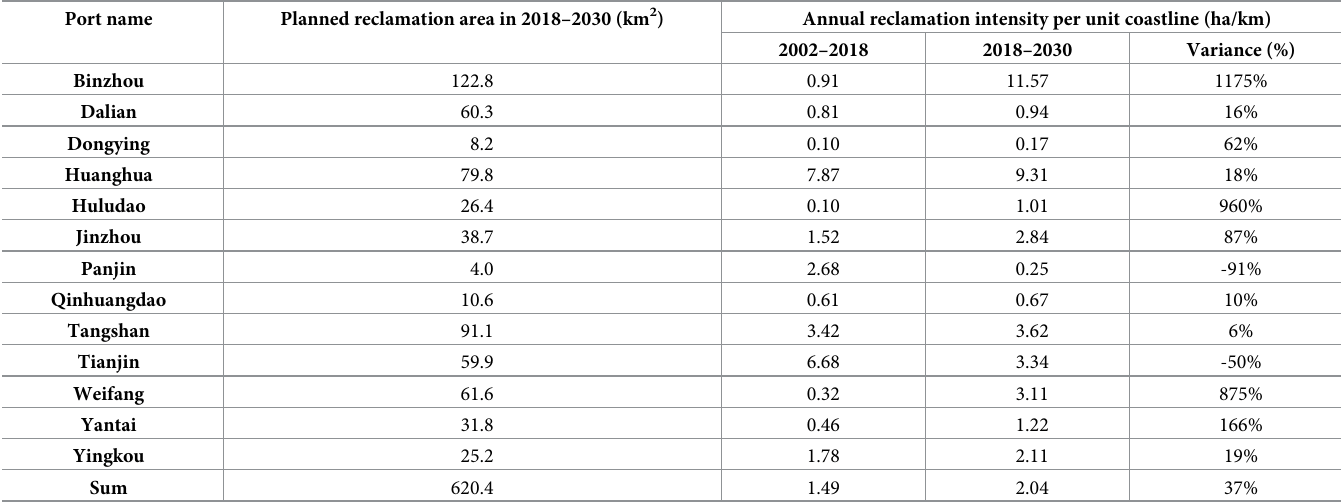
Table 5. Planned area and intensity of port clusters reclamation in the Bohai Sea in 2018–2030. Port